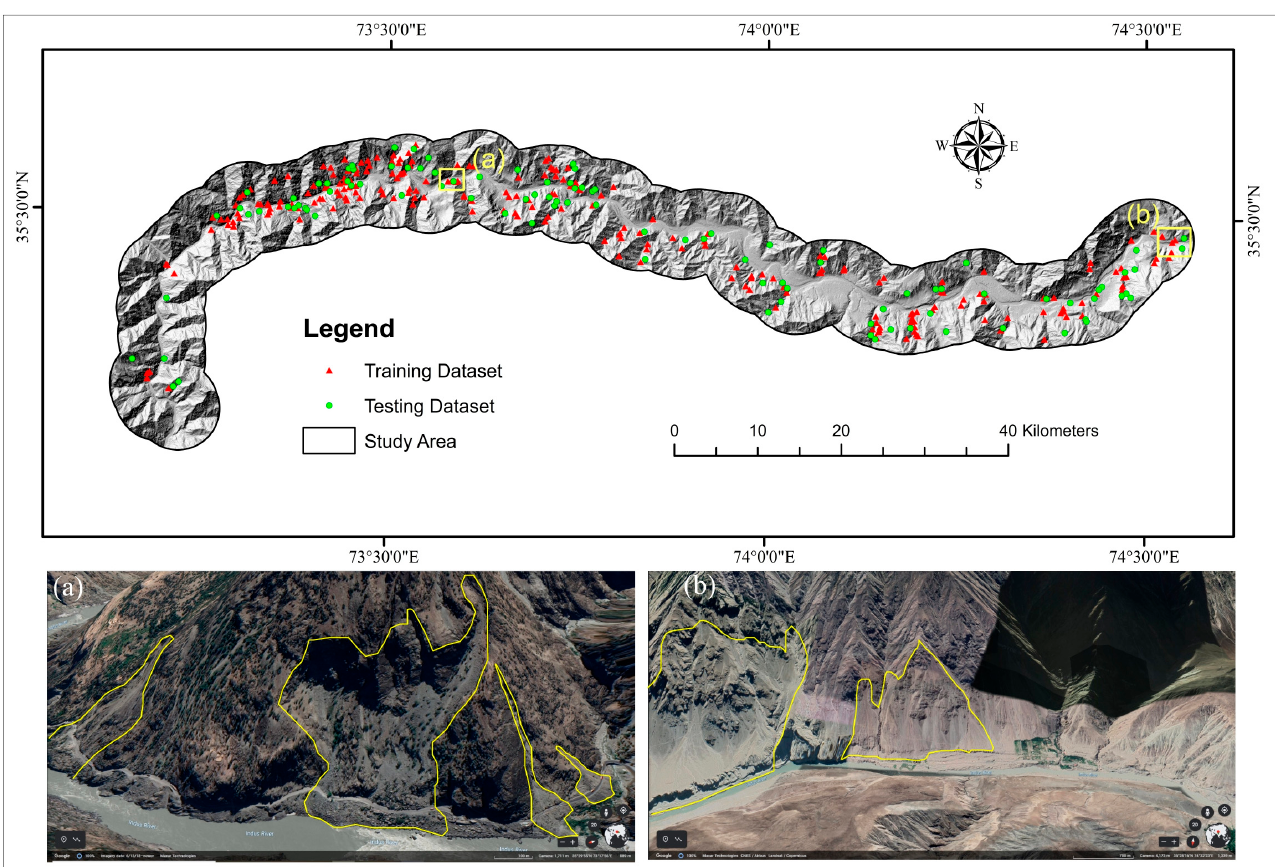
Figure 4. Showing the debris flow, rockfall, and scree slopes in the research area.